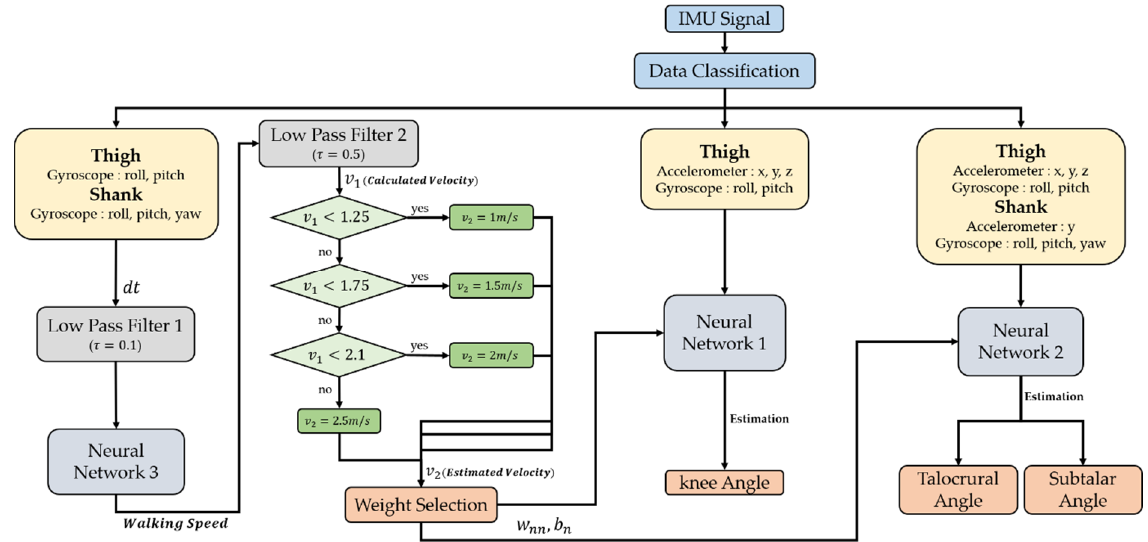
Figure 6. Schematic block diagram showing the sequence of algorithms for estimating knee and ankle angles according to walking speed. The contents of the neural network block are shown in Figure 4.